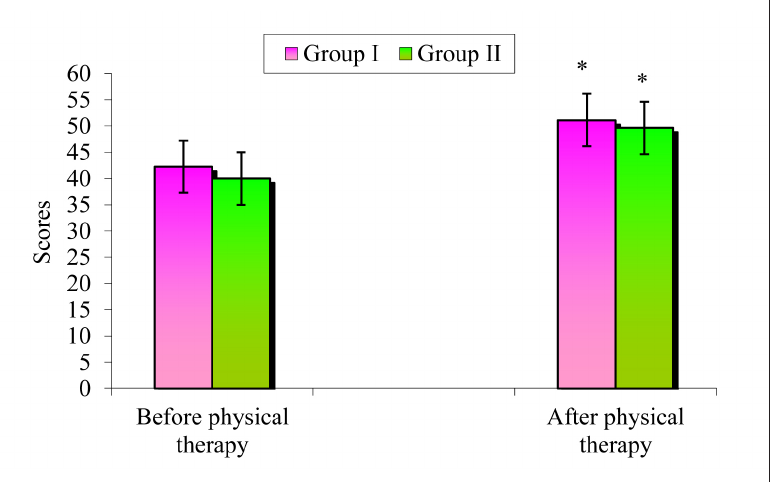
Figure 1. Mean Berg Balance Scale